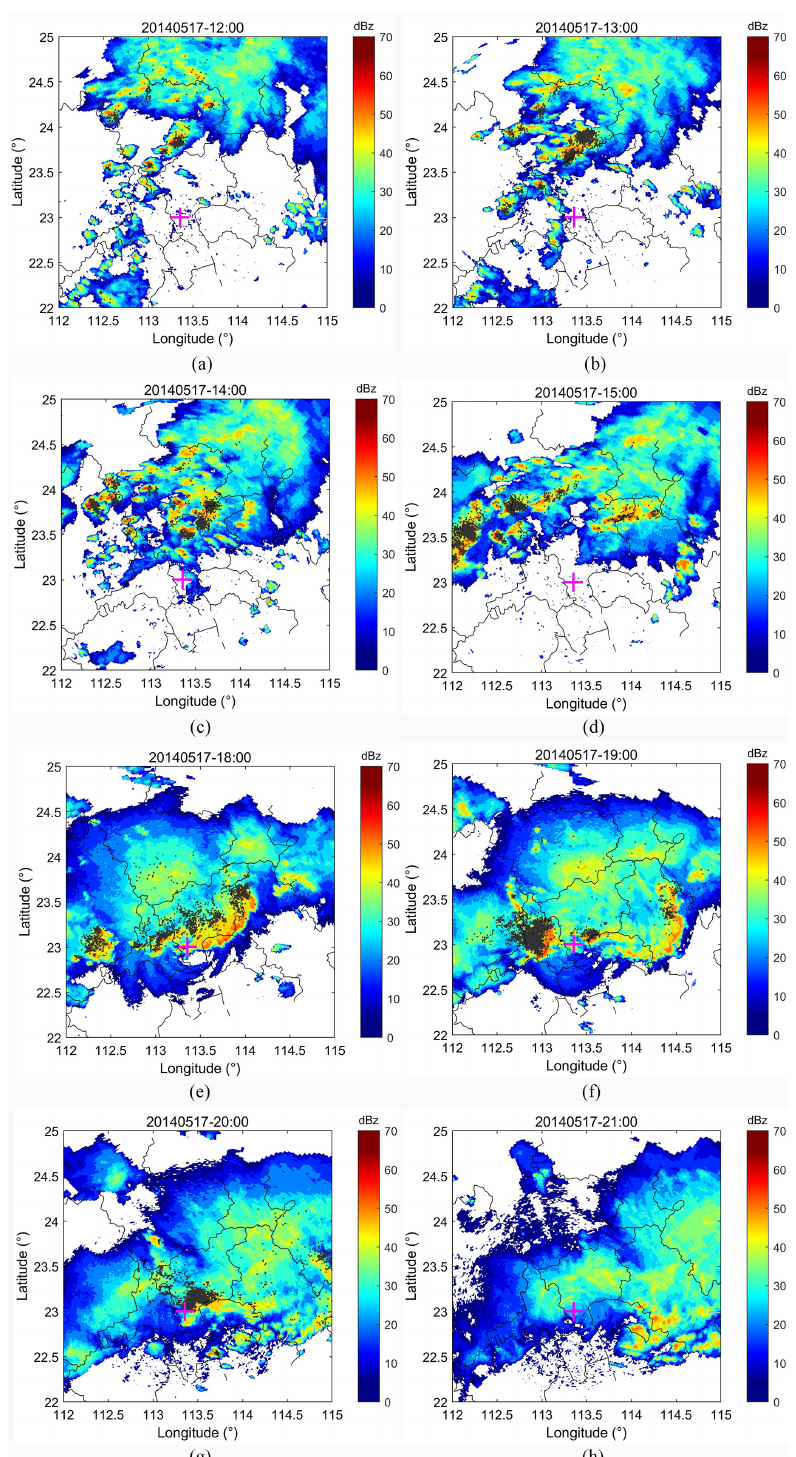
Figure 2. The stacking map of reflectivity scan by WSR-98D research radar and spatial distributions of total lightning data on 17 May 2014. Prominent areas of higher reflectivity are simultaneously covered by lightning events. The red plus represents the radar station which is situated on the east side of the